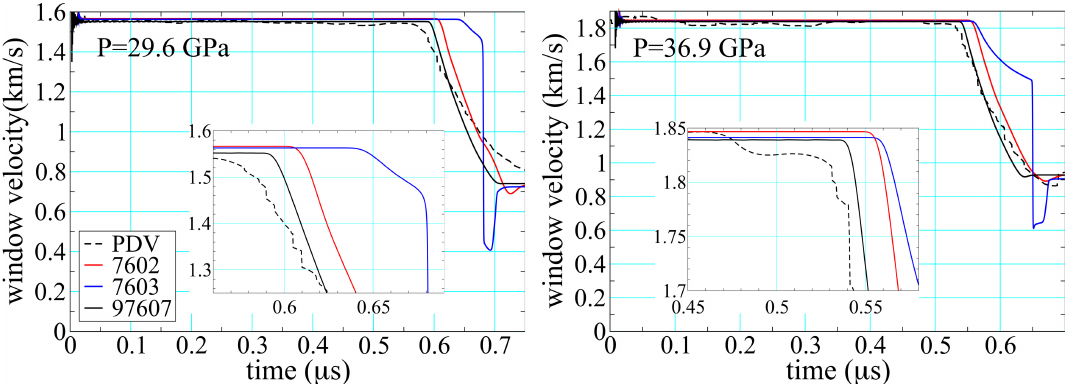
Figure 16. Particle velocity at the sample/window interface in deep-release experiments performed on epoxy; see Figure 9 for the experimental configuration. The average experimental PDV trace is dotted, while solid lines are results of hydrodynamic simulation performed with the SESAME EOS indicated and have the same color correspondence as those in Figure 15.